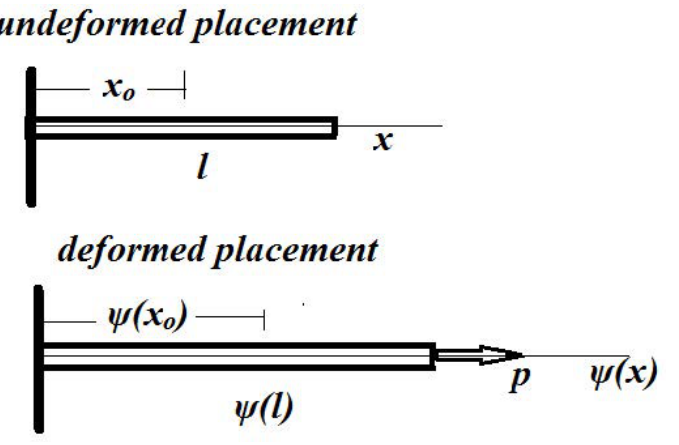
Figure 2. The bar in the initial space.